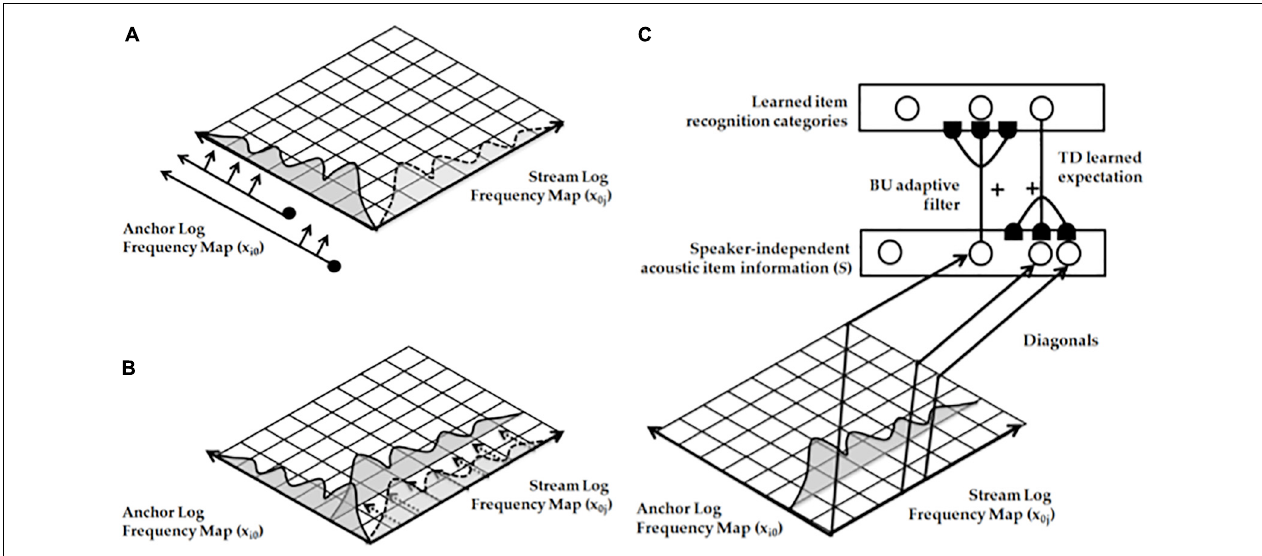
FIGURE 11 | The NormNet model (Ames and Grossberg, 2008) shows how speaker normalization can be achieved using specializations of the same mechanisms that create auditory streams. See the text for details.